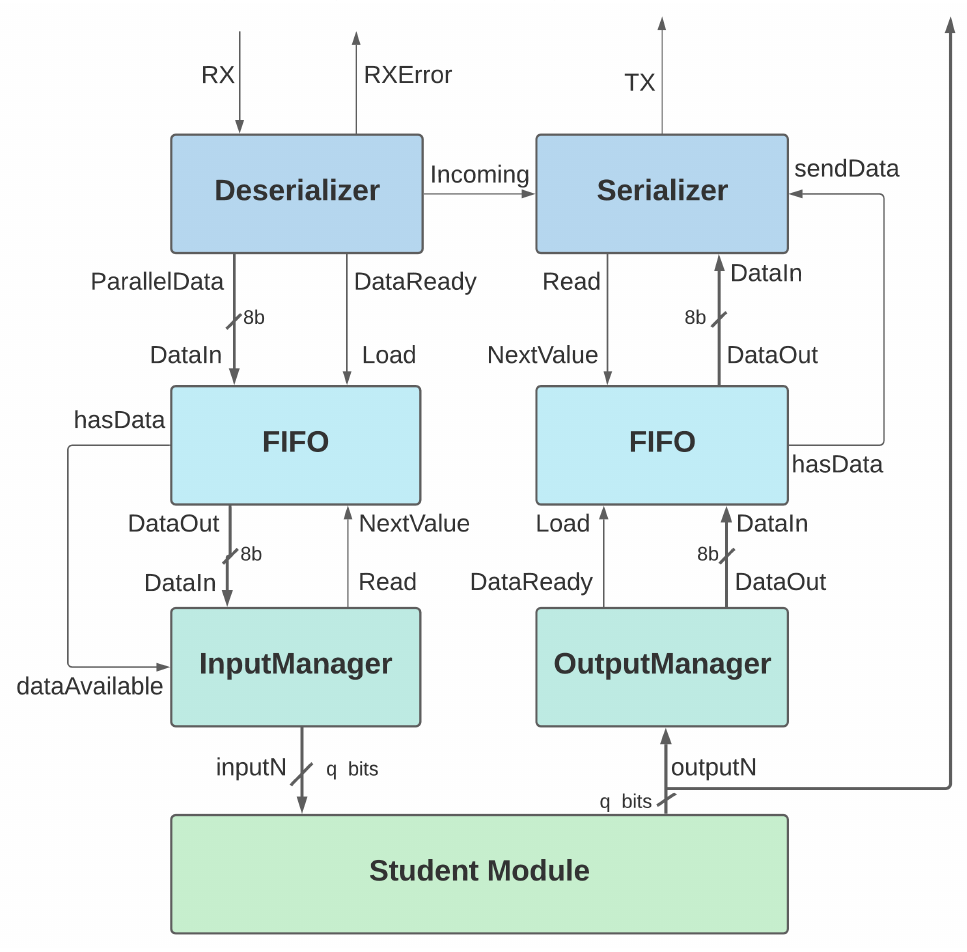
Figure 4. The FPGA architecture required for user module